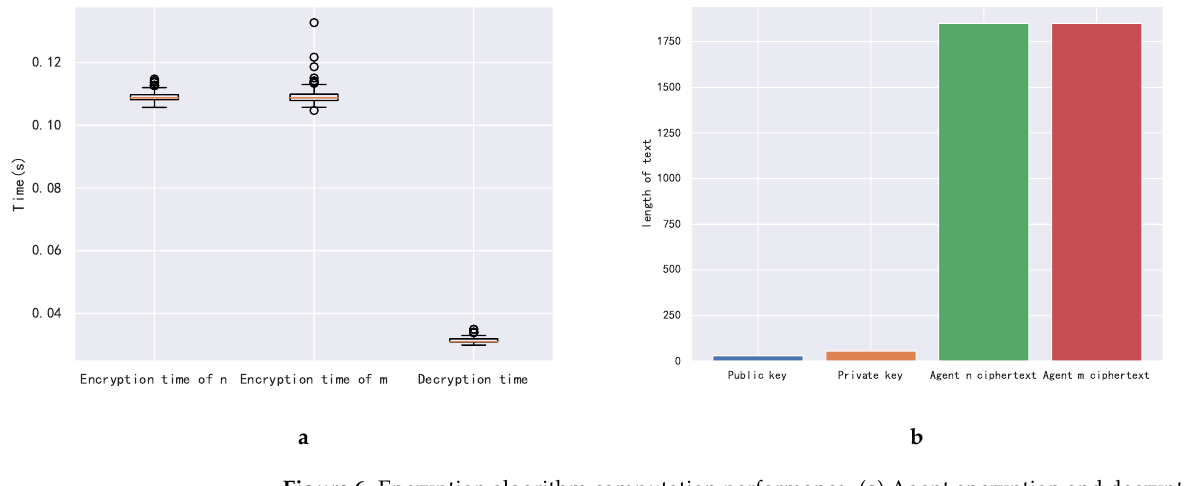
Figure 6. Encryption algorithm computation performance. ( a ) Agent encryption and decryption time. ( b ) The size of the public/private keys and ciphertext.